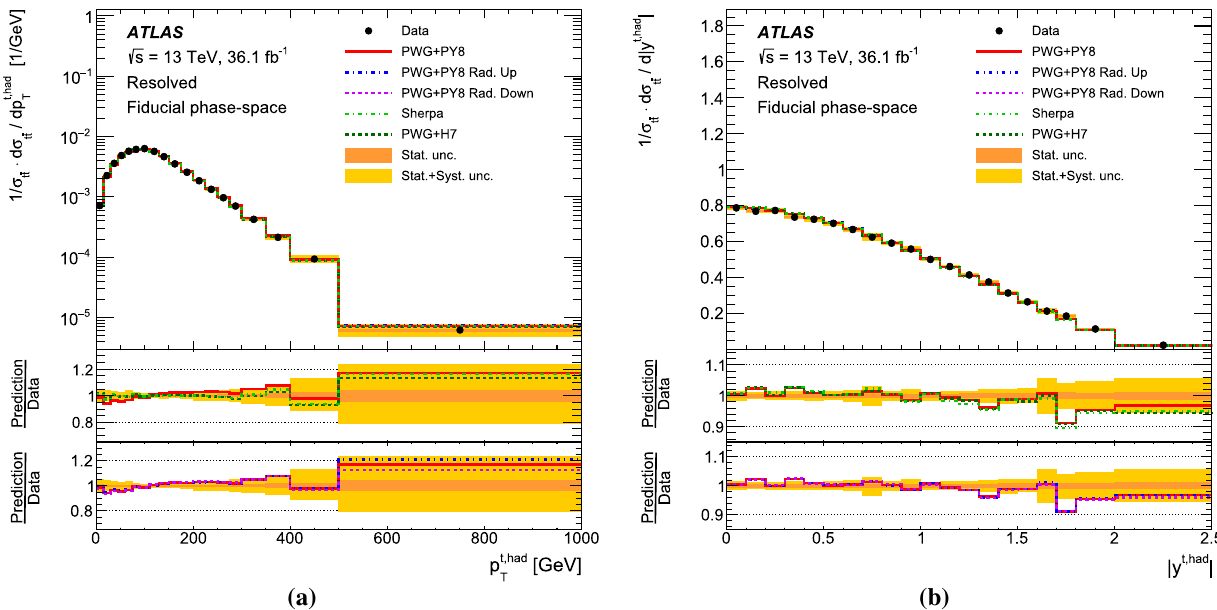
Fig. 22 Particle-level normalised differential cross-sections as a func- tion of a the transverse momentum and b the absolute value of the rapidity of the hadronically decaying top quark in the resolved topol- ogy, compared with different Monte Carlo predictions. The bands rep-